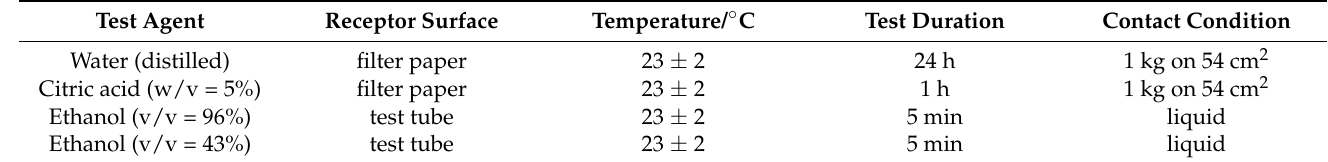
Table 3. Test conditions for used liquid agents